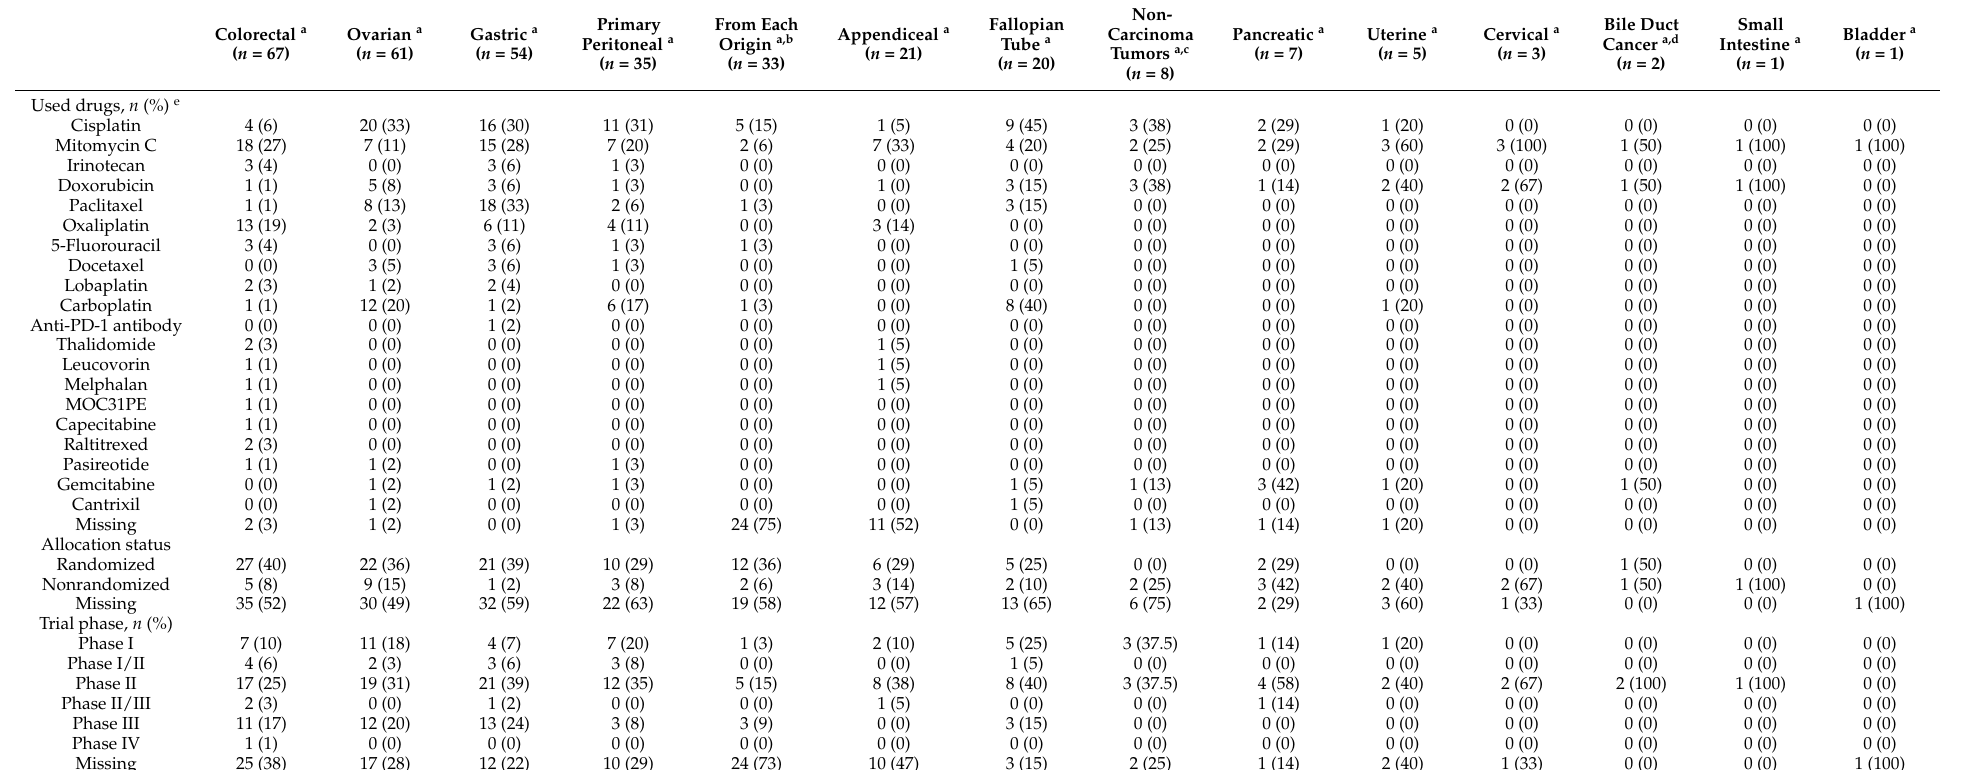
Table 2. Number of clinical trials involving different drugs by neoplasia